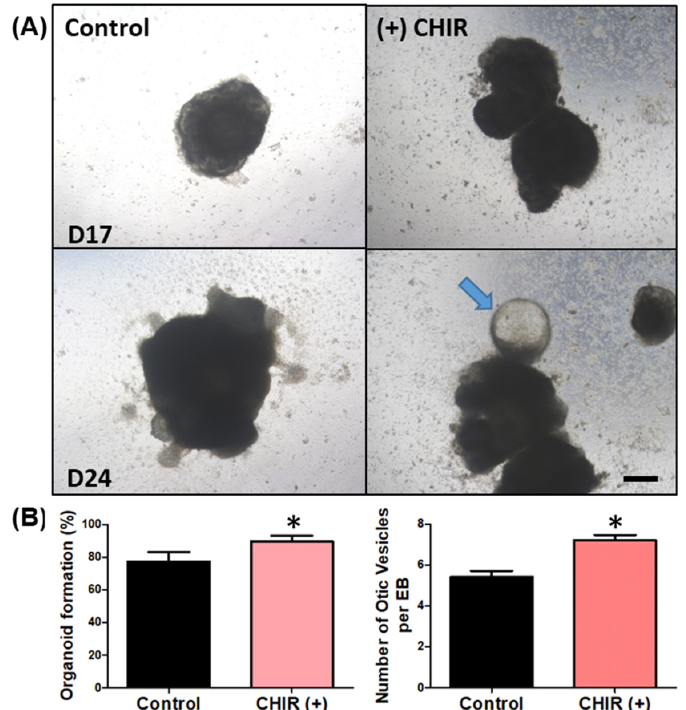
Figure 4. Wnt agonist (CHIR) application and possible otic organoids (cystic protrusions). The images in ( A ) show organoid differentiation at two time points: day 17 (D17) and day 24 (D24). The left column shows organoid differentiation without the Wnt agonist (CHIR), and the right column shows differentiation with CHIR. At D17, the control organoids had irregular surfaces but no definite protrusions, while the CHIR-treated EBs showed clearly protruding lesions around the surface. On D24, irregular surfaces started to develop into protruding lesions in the control organoids, while CHIR-treated EBs showed protrusions that were more enlarged with cystic organoids (arrow), resembling otic organoids. The scale bar in image ( A ) indicates 200 µm. We assessed the organoid formation rate and counted the number of organoids (vesicles) per EB. In the CHIR-treated group, the rate of organoid formation was significantly higher ( B ) and there were more organoids per EB ( C ). (* p < 0.05).